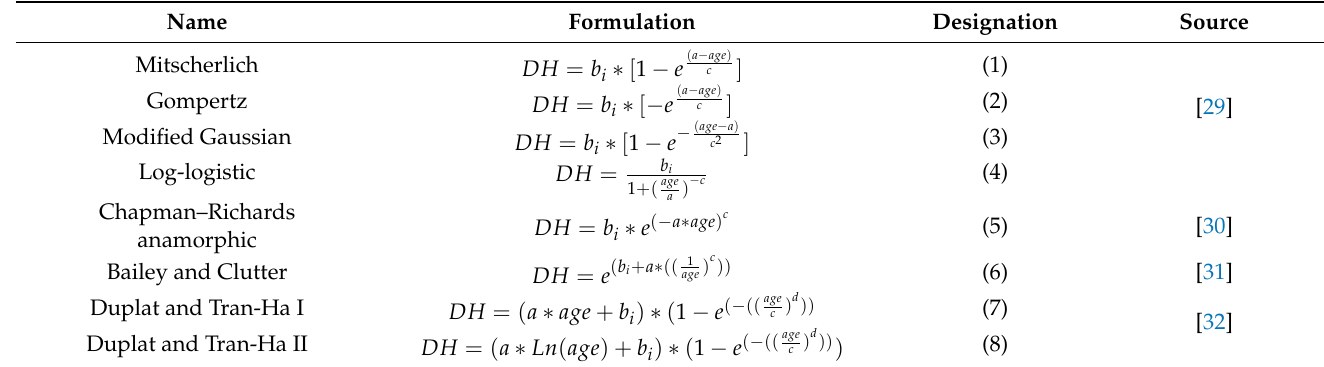
Table 2. Various forms of the growth functions (as base functions) tested for the dominant height growth models of larch. The parameter describing the productivity level is always represented by “ b i ” (asymptotic parameter), the shape parameters are represented by “ a ”, “ c ”, and “ d ”, and DH is dominant height.